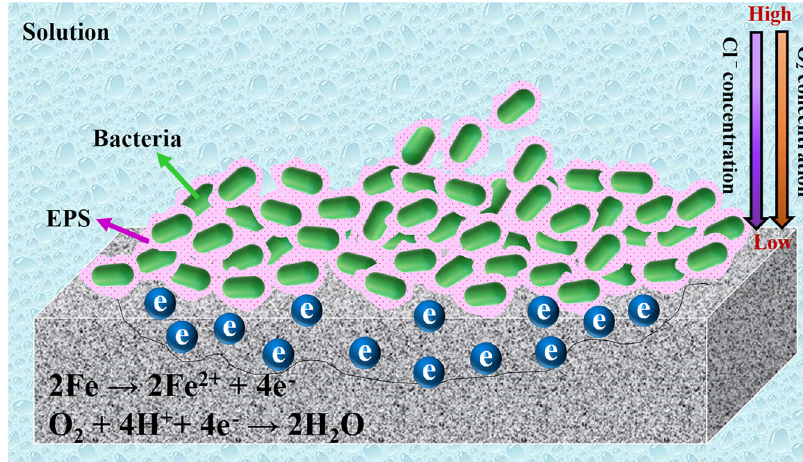
Fig. 9 MICI mechanism of X80. Schematic illustration of the proposed MICI mechanism of